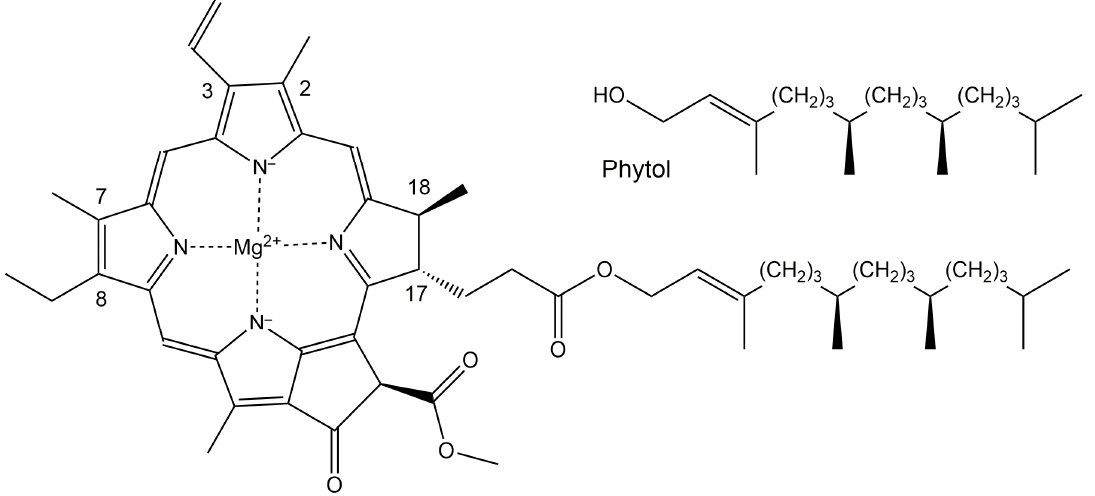
Figure 6. Structure of chlorophyll a, with numbering at the chlorin ring.